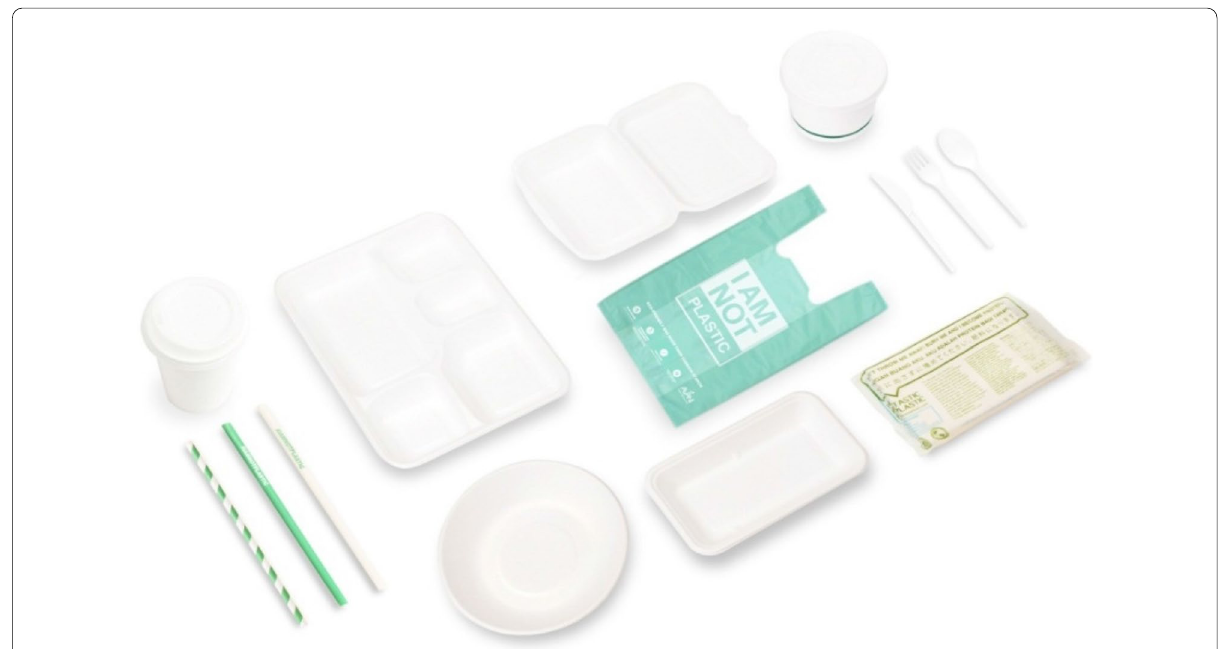
Fig. 3 Avani Eco, a sample of the biodegradable product, produced in Indonesia. Source: https:// www. avani eco. com/ wp- conte nt/ uploa ds/ 2019/ 10/ Banner- 1- Repla ce- plast ic- with. jpg, downloaded on March 28,